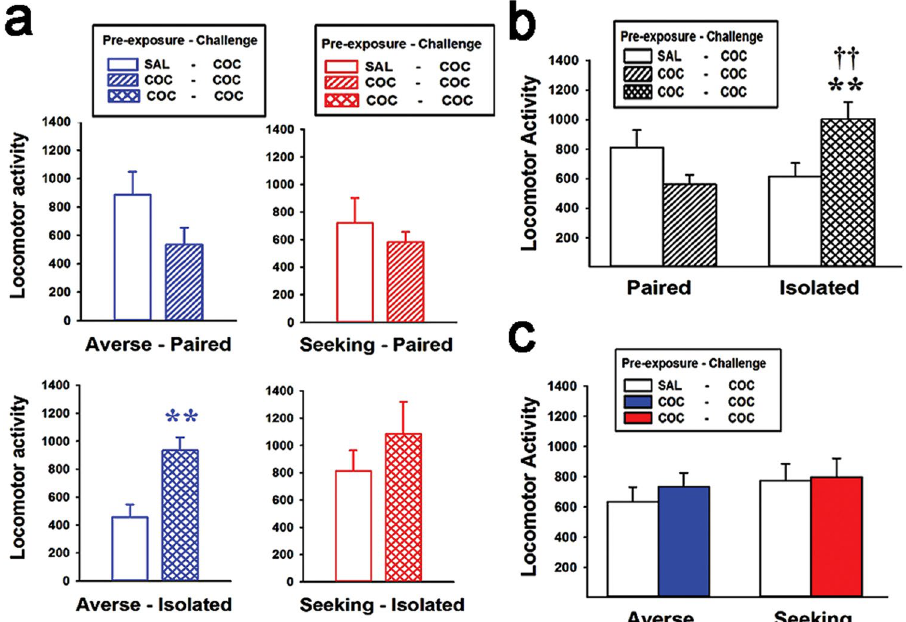
Figure 6. Locomotor activity. ( a ) During the cocaine challenge, locomotor activity (combined score of the horizontal locomotion and rearing) was significantly higher (i.e., locomotor sensitization) in cocaine compared to the saline pre-exposed sub-groups, but only in the averse-isolated group. ( b ) When the groups were combined and compared according to the housing environment (i.e., paired vs. isolated), locomotor sensitization only occurred in the isolated groups. ( c ) There was no significant difference between the averse and seeking groups when